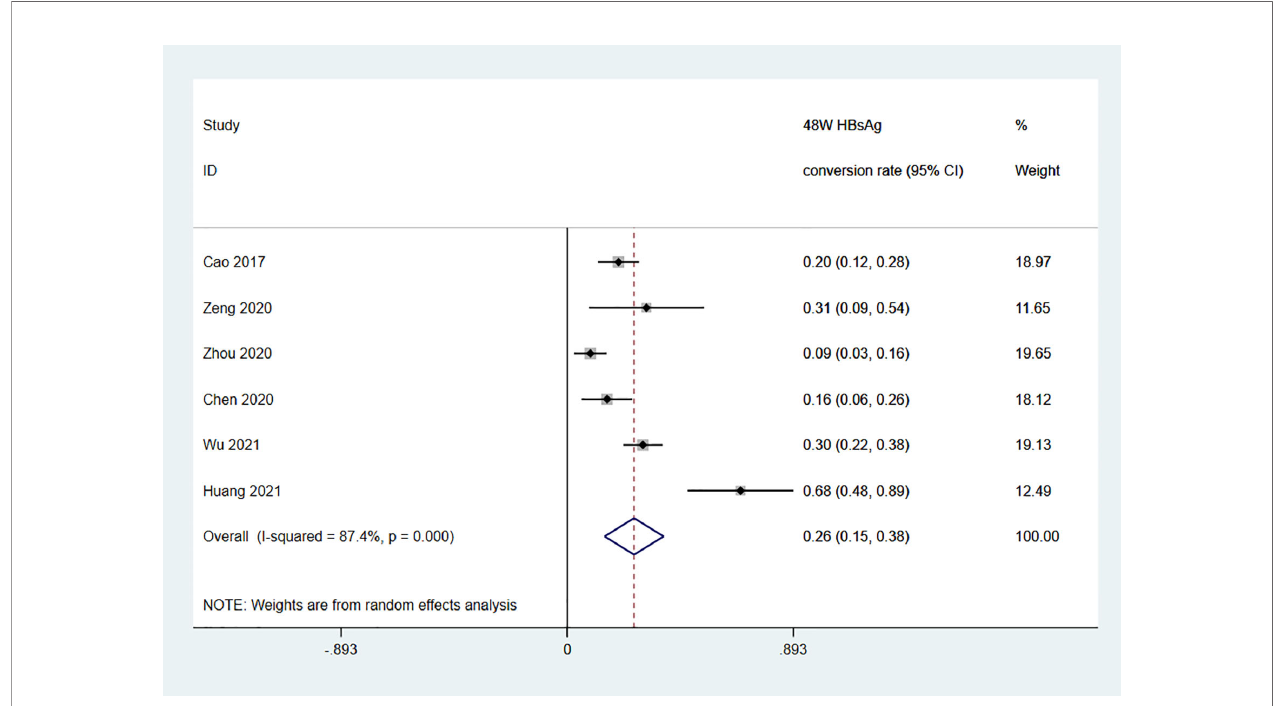
FIGURE 3 | Meta-analysis of the HBsAg conversion rate among IHCs after 48-W Peg-IFN